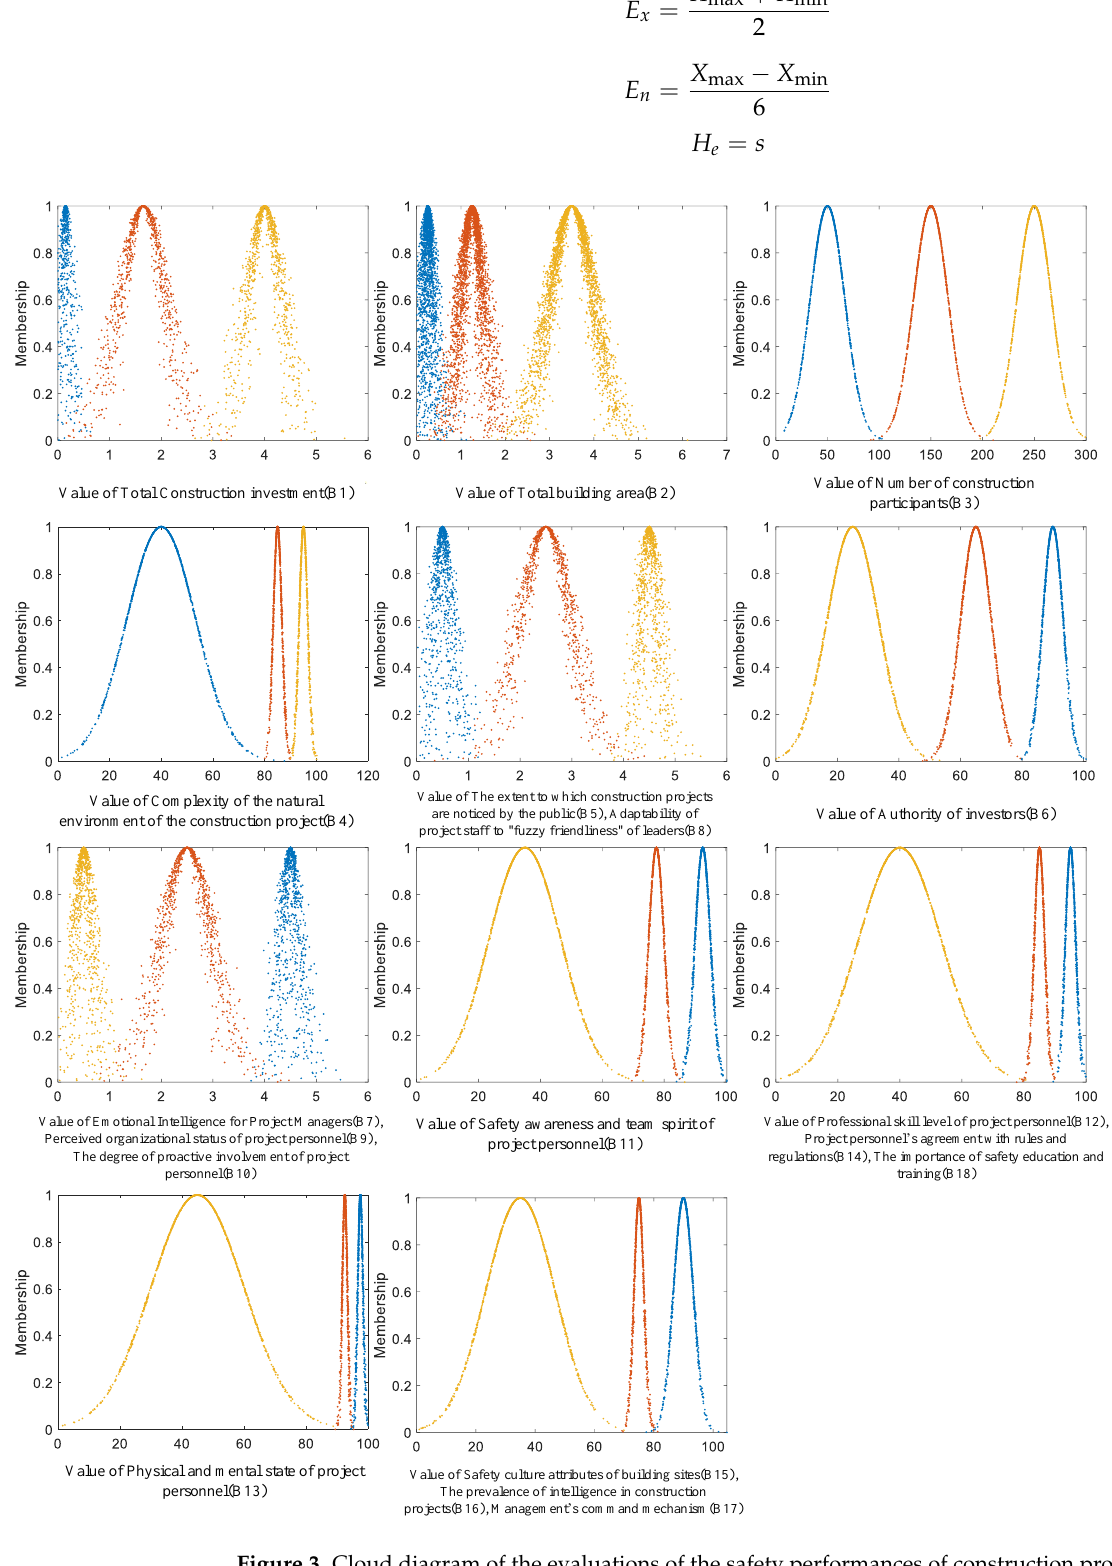
Figure 3. Cloud diagram of the evaluations of the safety performances of construction projects under the influences of psychological